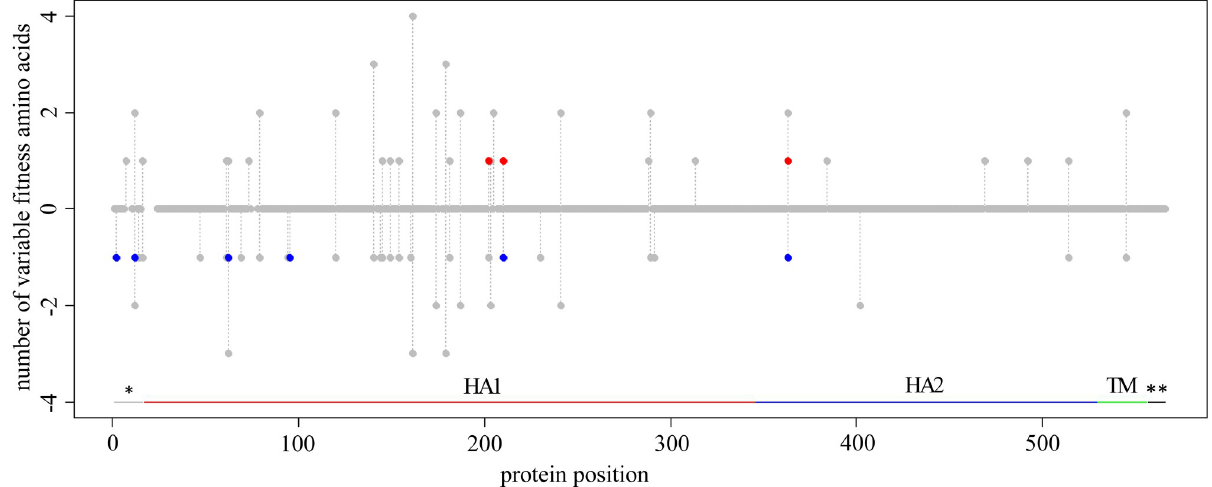
Fig 7. Amino acid sites carrying variable fitness amino acids in HA of influenza A virus. For each protein position (horizontal axis), the red dot shows the number of amino acids that are simultaneously proximal to the H1 strain and distal from the H3 strain, and the blue dot, the number of amino acids that are simultaneously proximal to the H3 strain and distal from the H1 strain, multiplied by -1. Grey dots represent the number of testable amino acids (see Materials and methods). The positions without any dots are sites filtered out due to alignment ambiguity. Vertical grey lines connect dots for the same site. Protein domains are marked by horizontal lines: � , signal peptide; HA1, HA1 ectodomain; HA2, HA2 ectodomain; TM, transmembrane domain; �� , cytoplasmic tail; numeration of protein positions is A/Perth/16/2009 based.